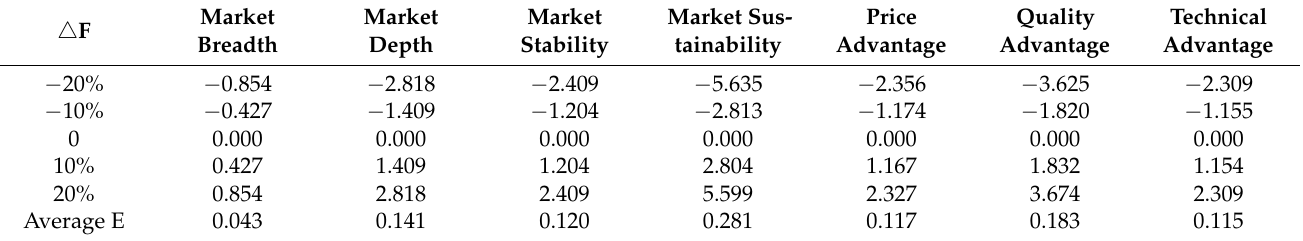
Table 9. Single factor sensitivity analysis results of the international competitiveness